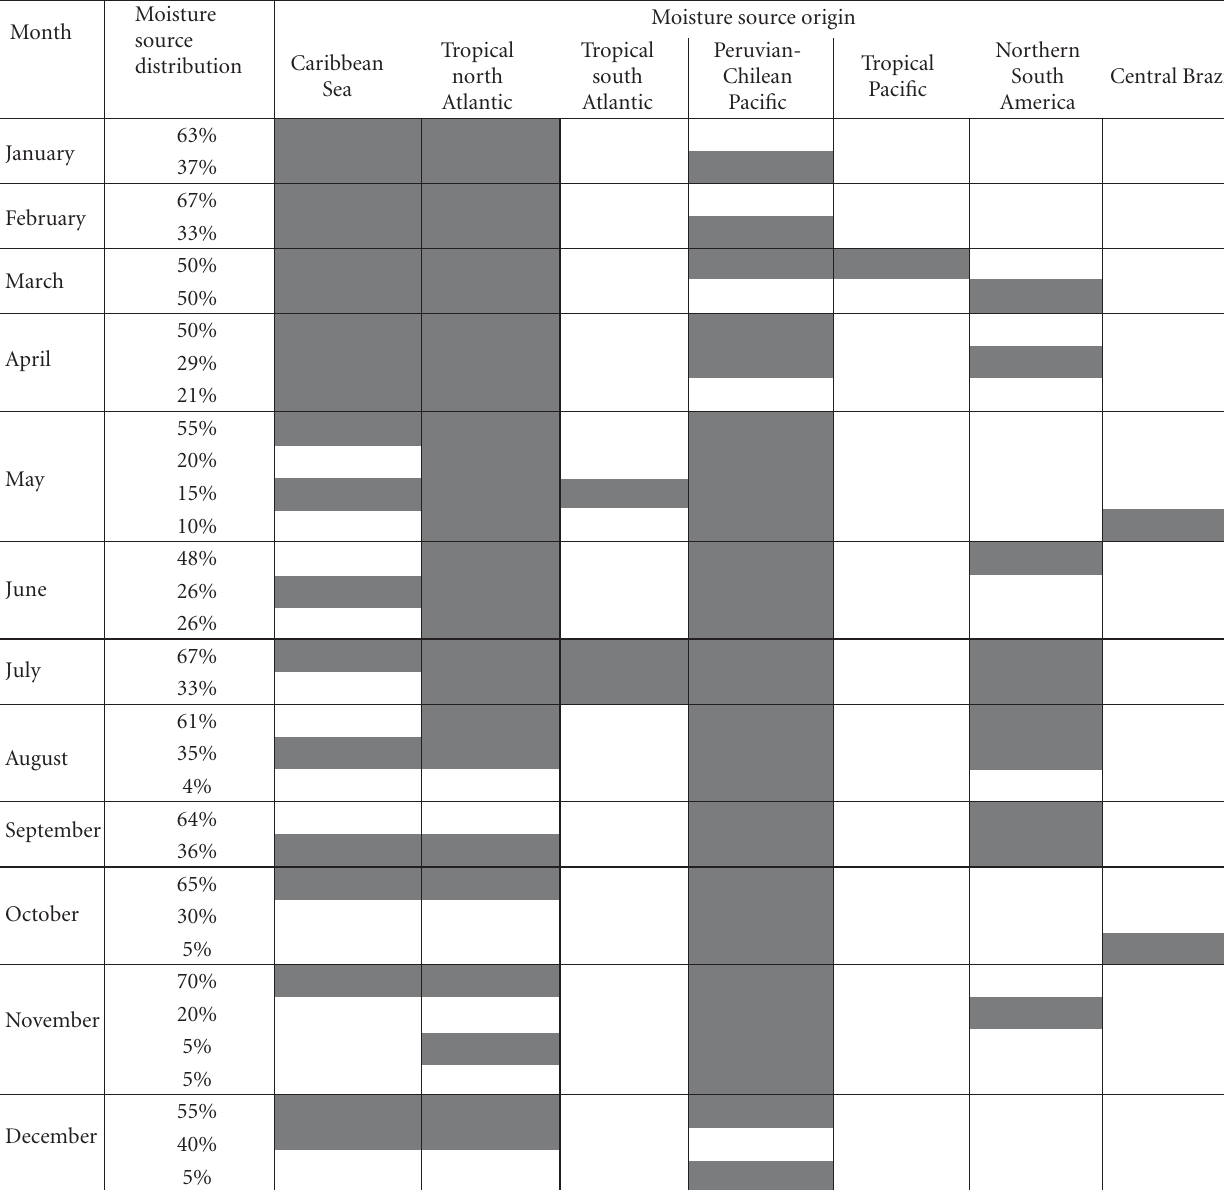
Table 3: Same as Table 2 but considering oceanic convective system